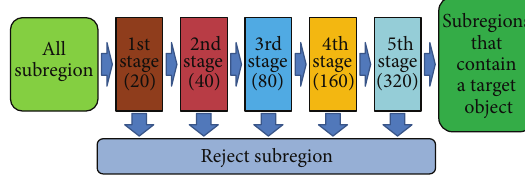
Figure 10: Cascade structure of